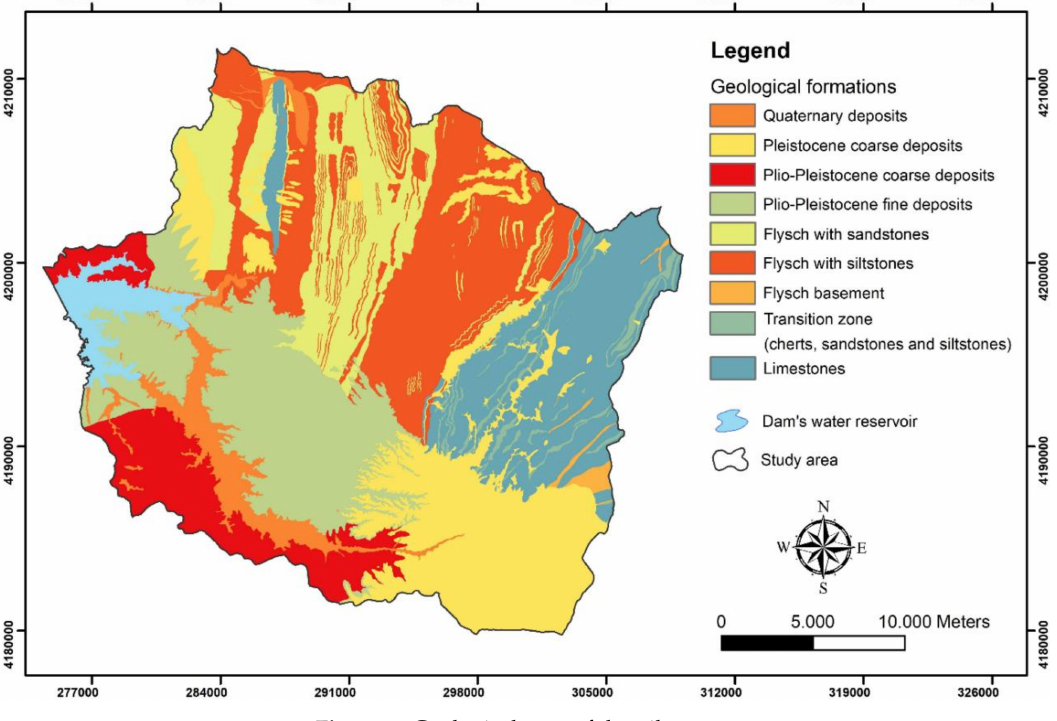
Figure 5. Geological map of the pilot